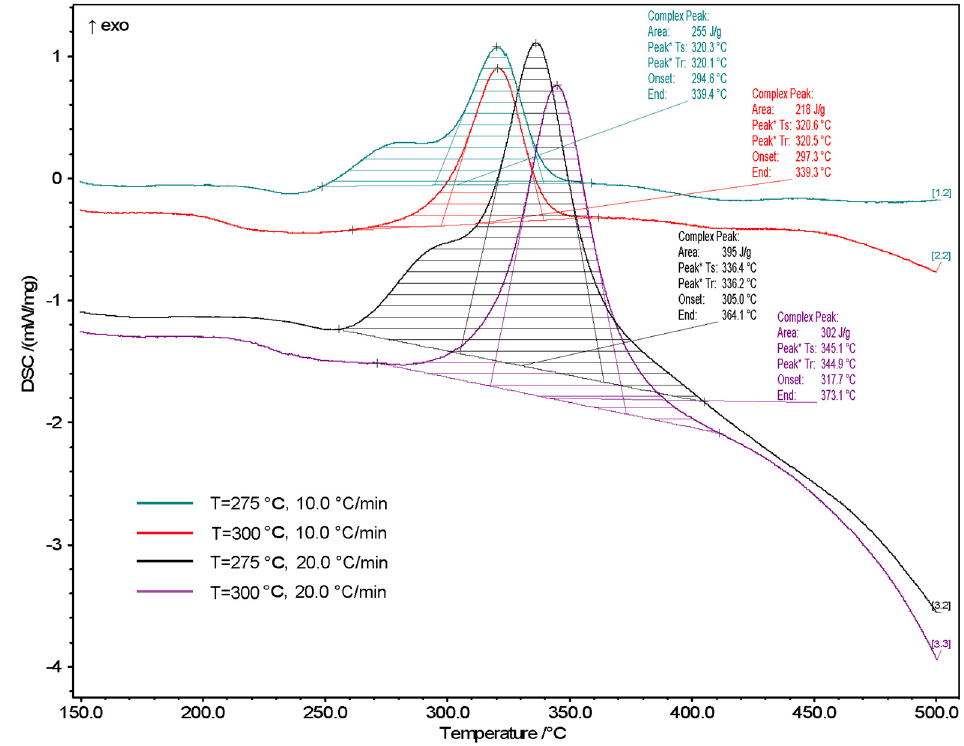
Figure 10. DSC analysis of torrefied Miscanthus 257 °C and 300 °C (heating ratios: 10, 20 K/min) in an N 2 atmosphere.